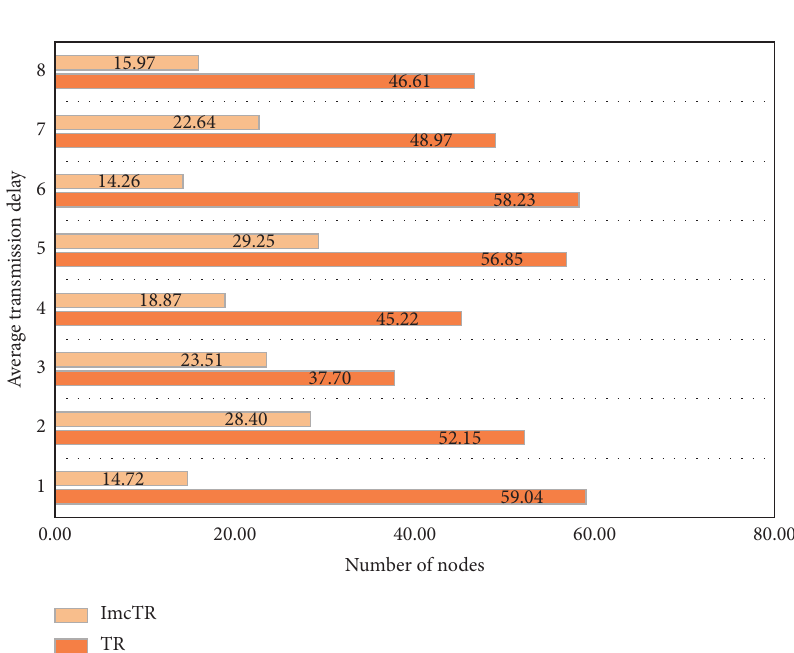
Figure 4: End-to-end average delay.